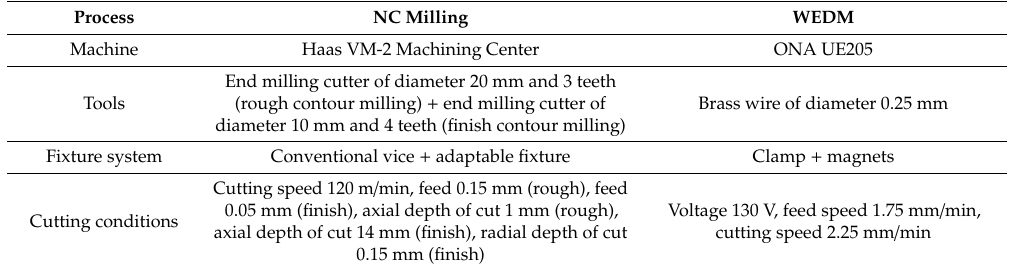
Table 3. Main parameters of the manufacturing process of the cam .